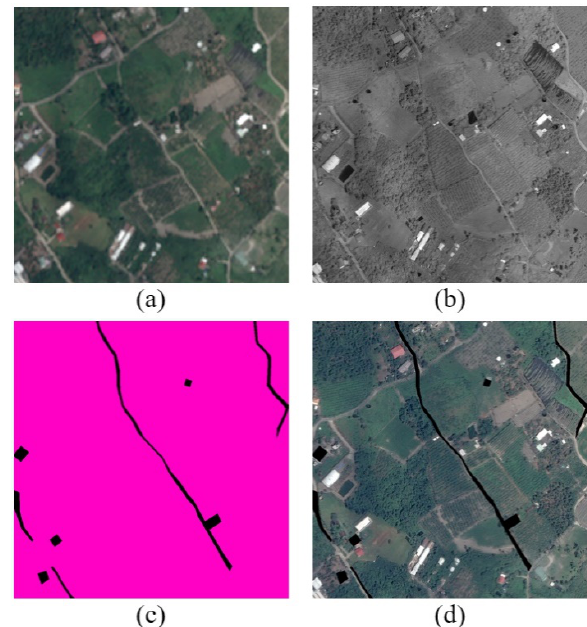
Figure 2 . Data pre-processing. (a) multispectral image; (b) panchromatic image; (c) non-agricultural mask shown as black area; (d) pansharpened image with agricultural area.